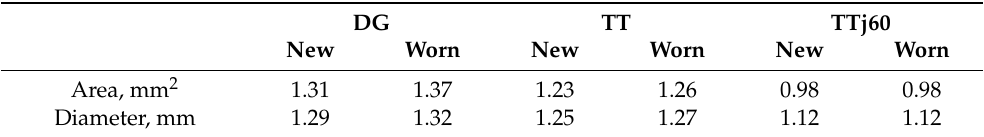
Table 3. Orifice area and diameter for the DG, TT, and TTj60 nozzles before (New) and after finishing the accelerated wear test (Worn).